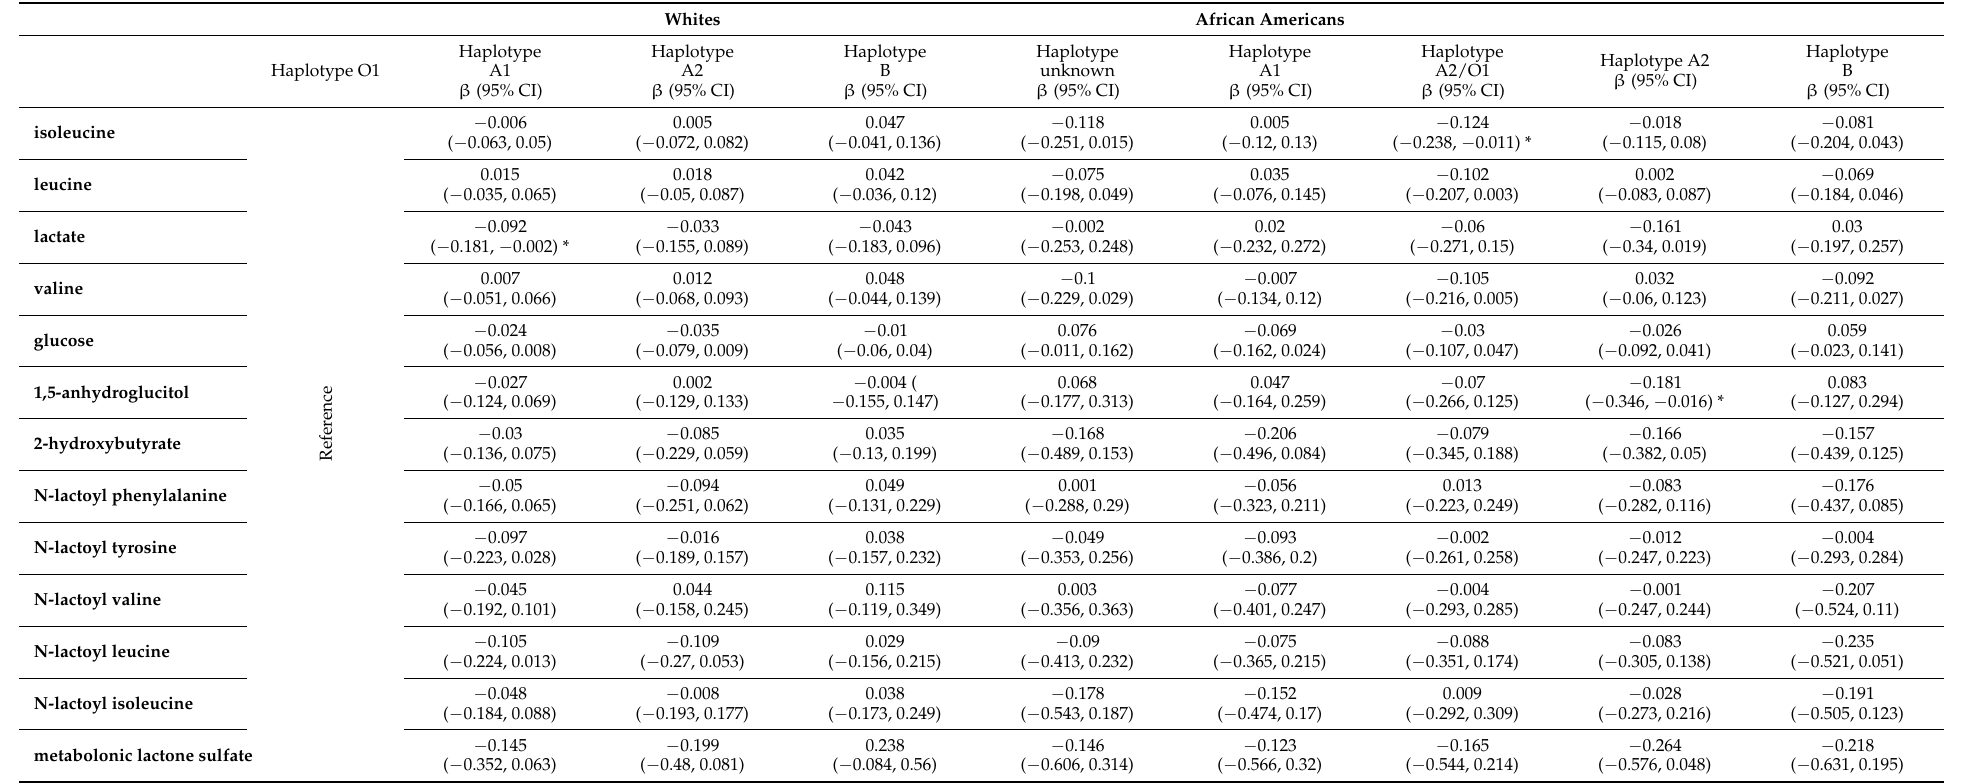
Table 4. The associations between ABO haplotypes and selected metabolites in the MILES